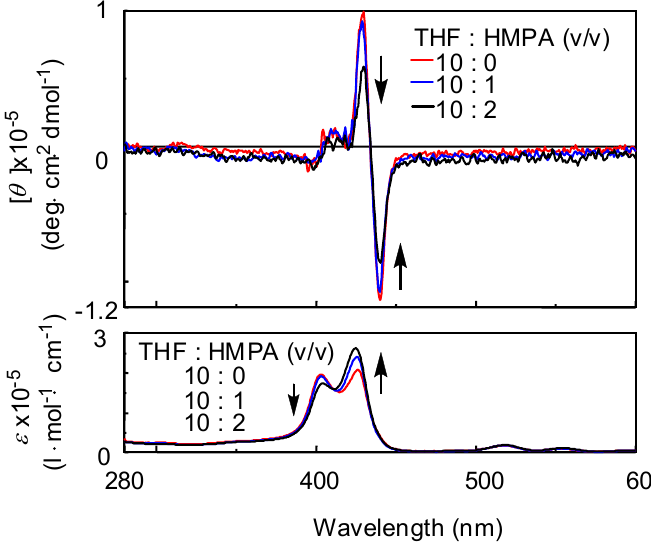
Figure 3. CD and UV-vis spectra of poly( 1 ) measured in THF/HMPA at room temperature.